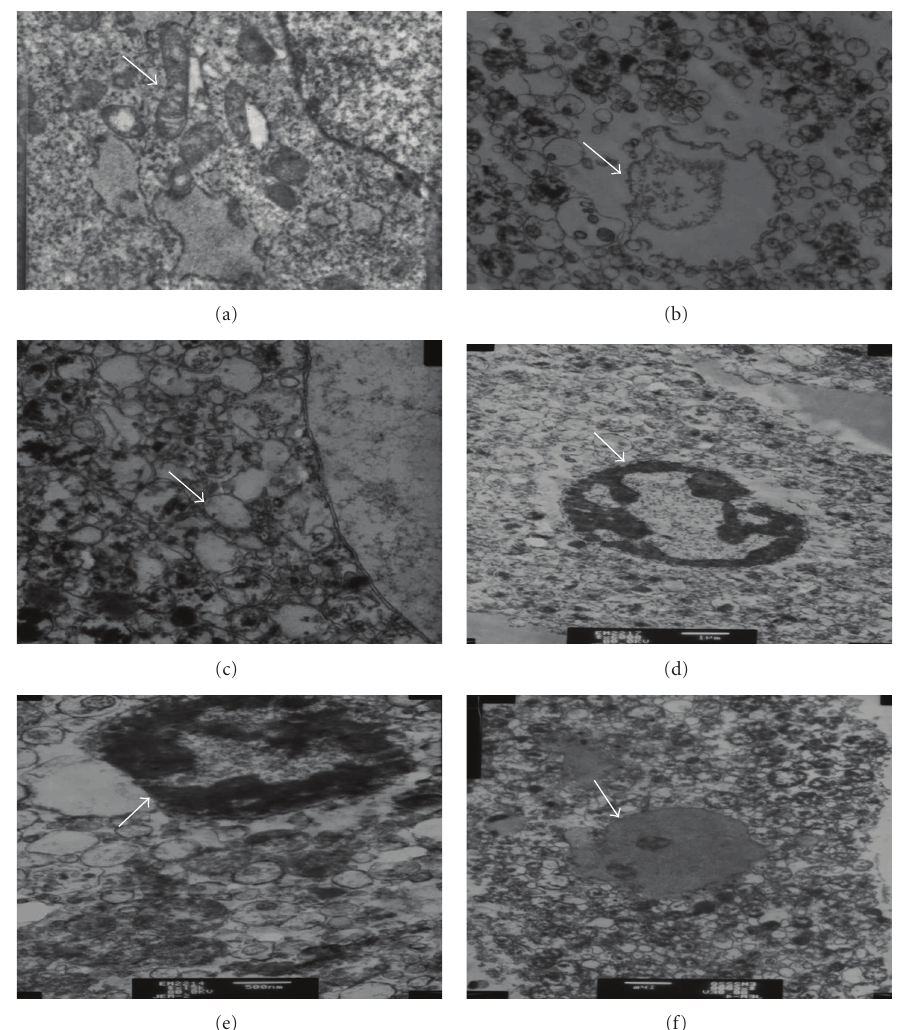
Figure 5: Ultrastructure alterations of hepatocytes (a) Control group, Nomal appearance of mitochondrion, nucleus struct. (X = 12 000) (b) H/R group, Mitochondrial crista destruction and nucleus structure destruction. (X = 12 000) (c) Wy14643 100 × 10 − 6 mol/L group, Nomal appearance of mitochondrion and nucleus structure almost. (X = 12 000) (d) Wy14643 30 × 10 − 6 mol/L group, Mitochondrion swellen mildly and nucleus structure are nomal nearly. (X = 12 000) (e) Wy14643 10 × 10 − 6 mol/L group, Mitochondrion swellen significantly, vacuolar degeneration and mitochondrial crista destruction, nucleus structure destruction. (X = 12000) (f) DMSO group, Mitochondrion swellen significantly, vacuolar degeneration and mitochondrial crista destruction, nucleus structure destruction. (X = 12